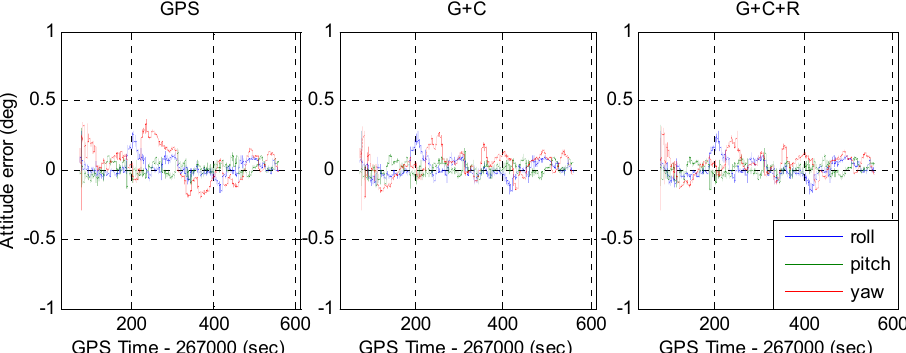
Figure 19. Attitude error of the tightly coupled RTK/INS integration for the GPS, GPS + BDS (G + C), and GPS + BDS + GLONASS (G + C + R) systems.